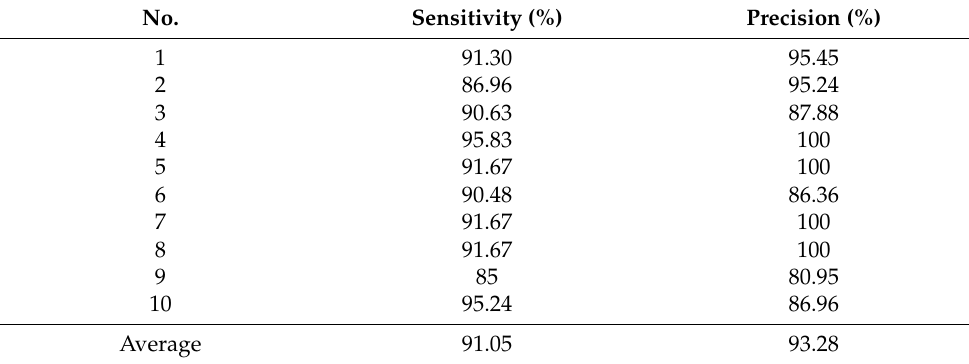
Table 6. Performance analysis for 10